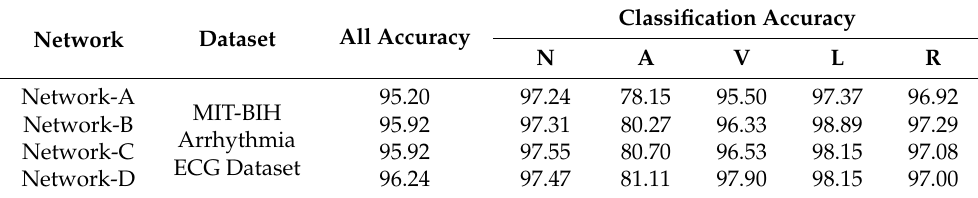
Table 3. Test results of all networks on type I data.